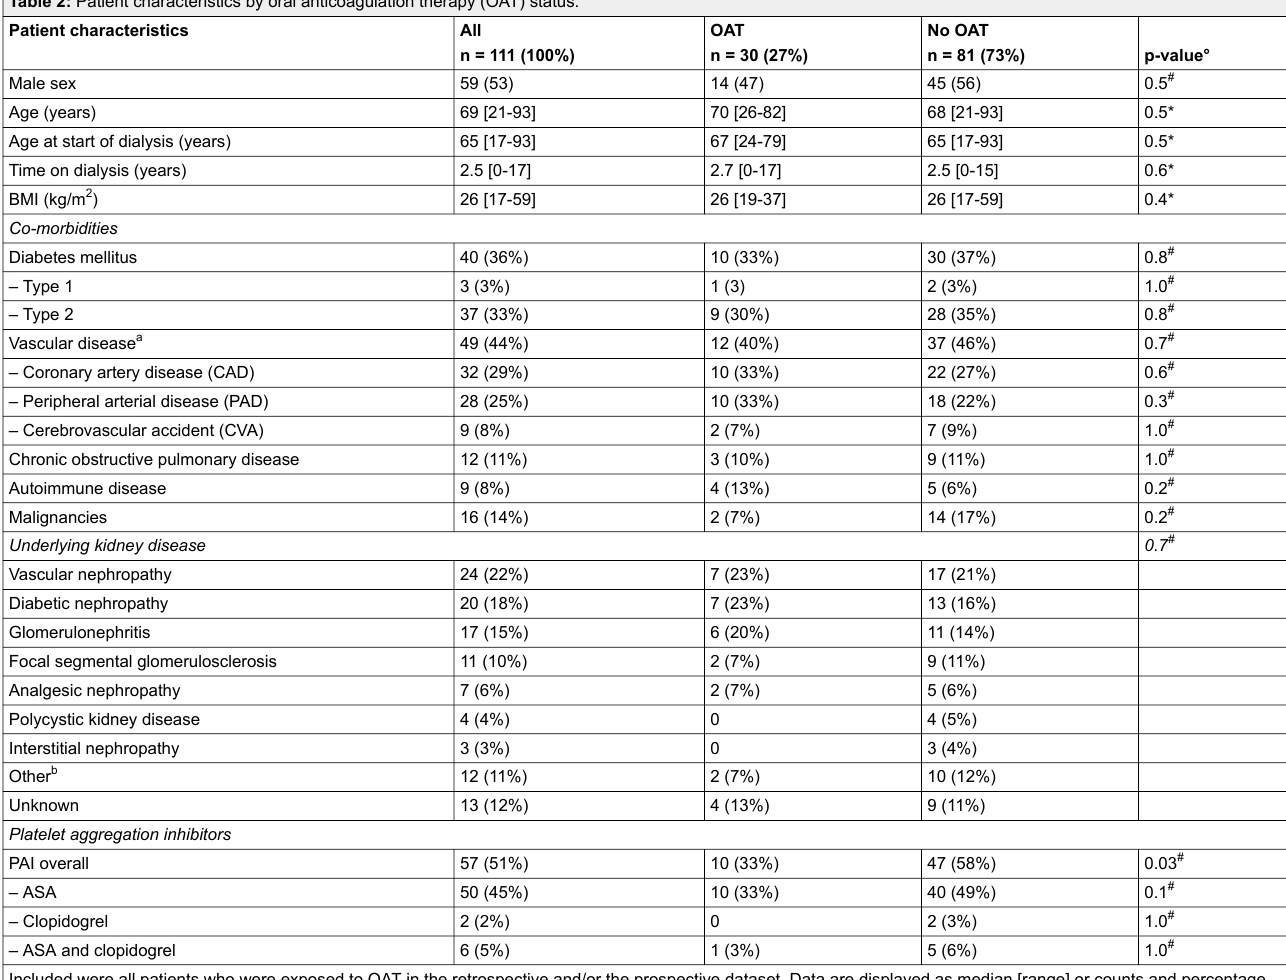
Table 2: Patient characteristics by oral anticoagulation therapy (OAT) status. Patient characteristics